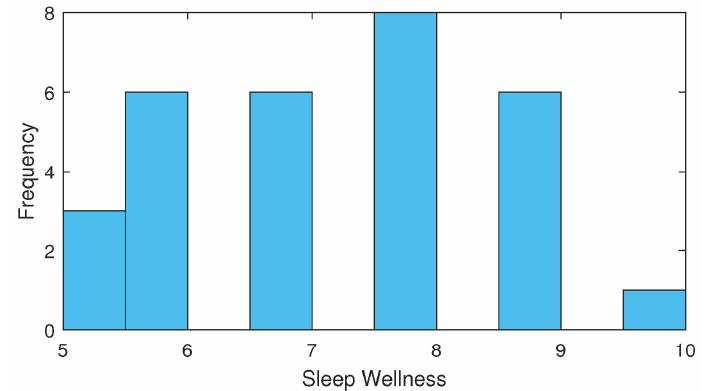
Figure 14. Wellness After Experiment First